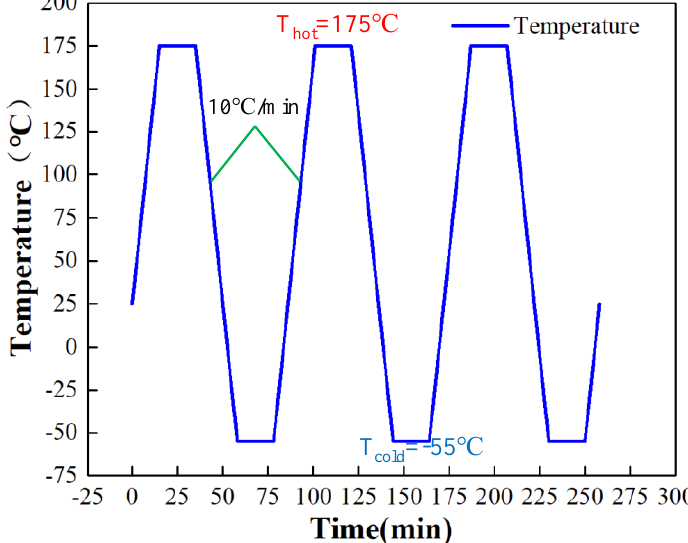
Figure 2: Cyclic temperatures in thermal fatigue